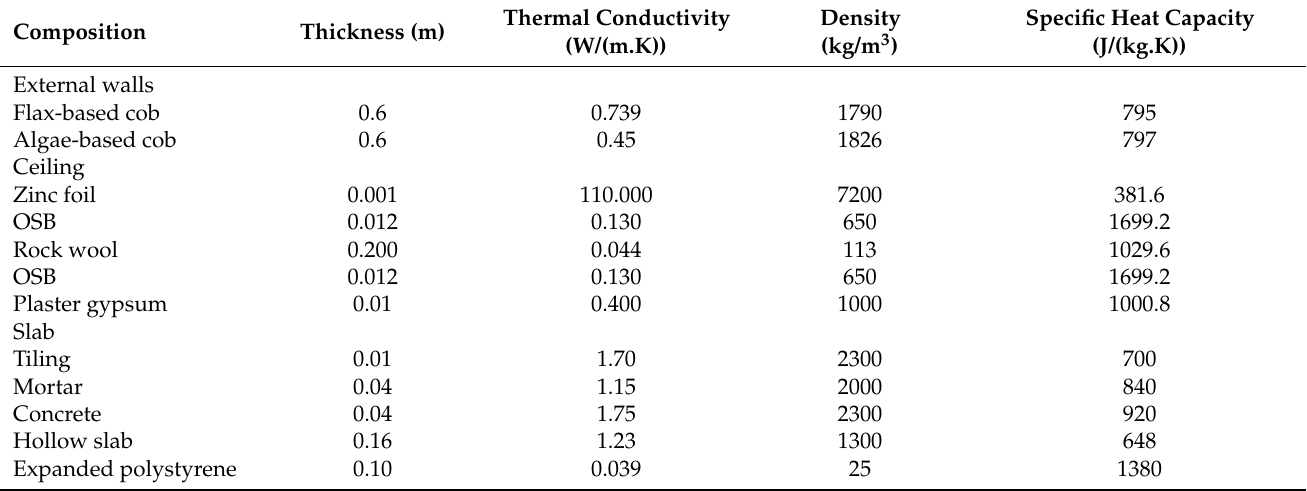
Table 10. Thermal properties of the materials constituting the building envelope.